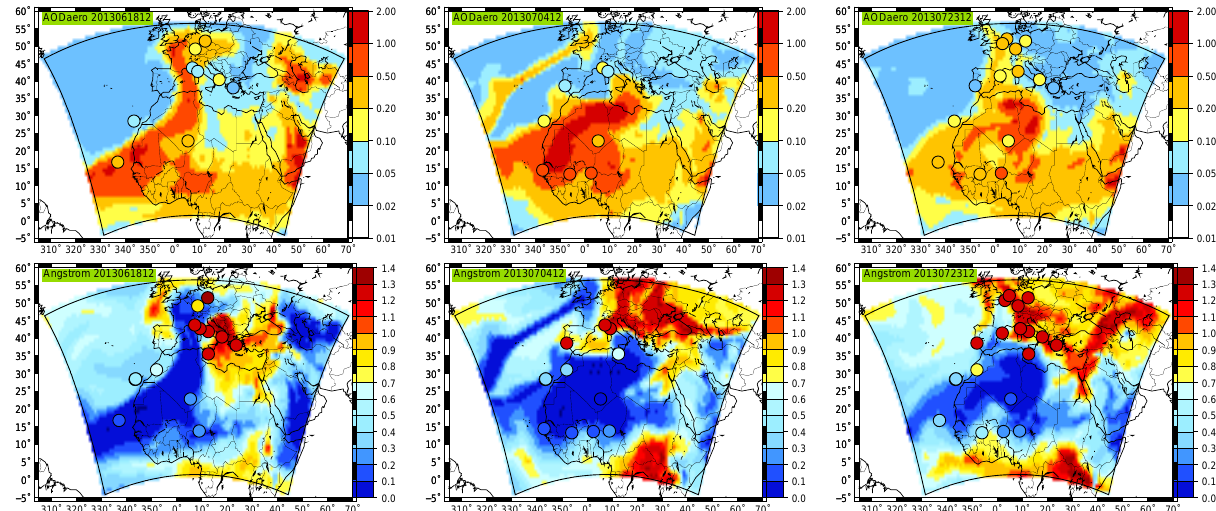
Figure 3. Maps for three different days – (left) 18 June, (middle) 4 July and (right) 23 July – and for the AOD (top) and the Ångström exponent (bottom). The AERONET measurements are superimposed to the modeled maps in colored